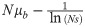
HIV within-host evolution is likely to be affected by interference effects.Examples of the function Nμb-1ln(Ns) over a wide range of values of N for μ
b = 10−4 and for s = {0.01, 0.05, 0.5}. The red points are the threshold values N
0 for each example function. N
0 varies only by about one order of magnitude over the range of relevant HIV selection coefficients.